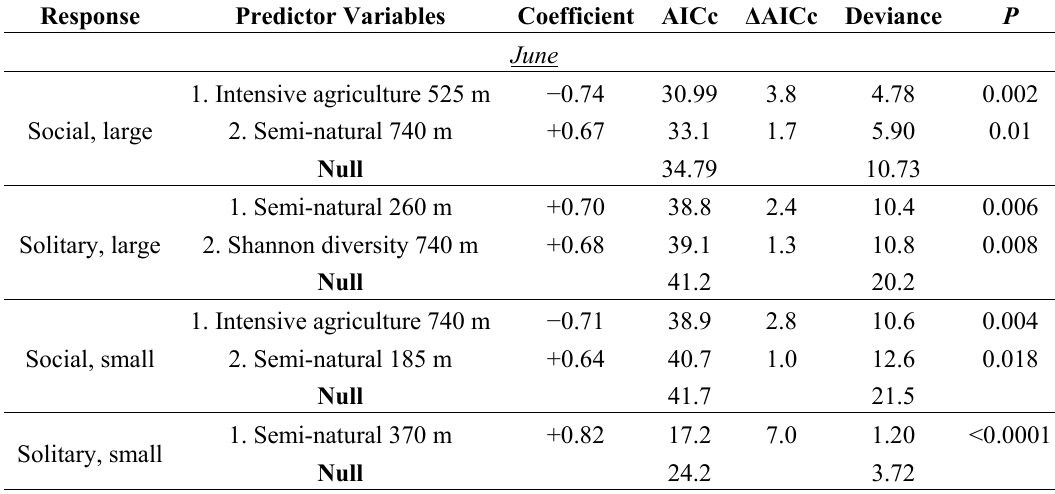
Table 2. Summary of regression results for the effects of vegetation composition and surrounding land cover on the abundance of bees in 10 conservation